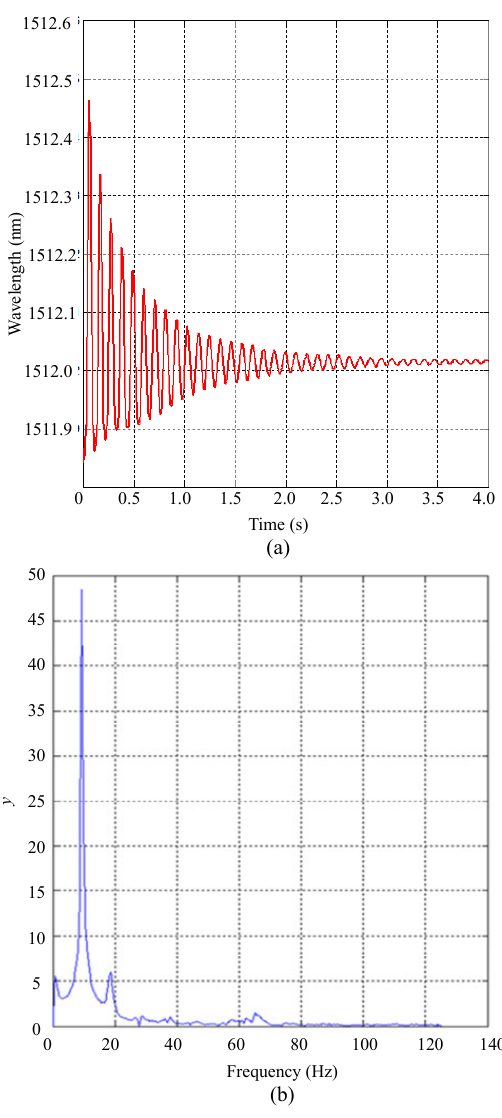
Fig. 8 Sensor rod vibration with (a) FBG wavelength change and (b)